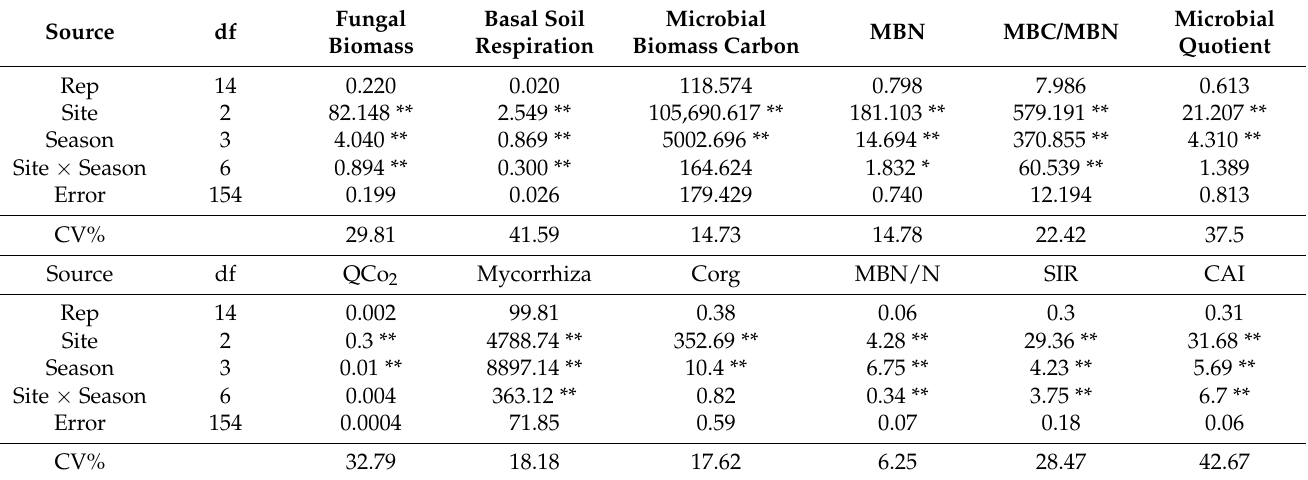
Table 4. Analysis of variances for the soil biological